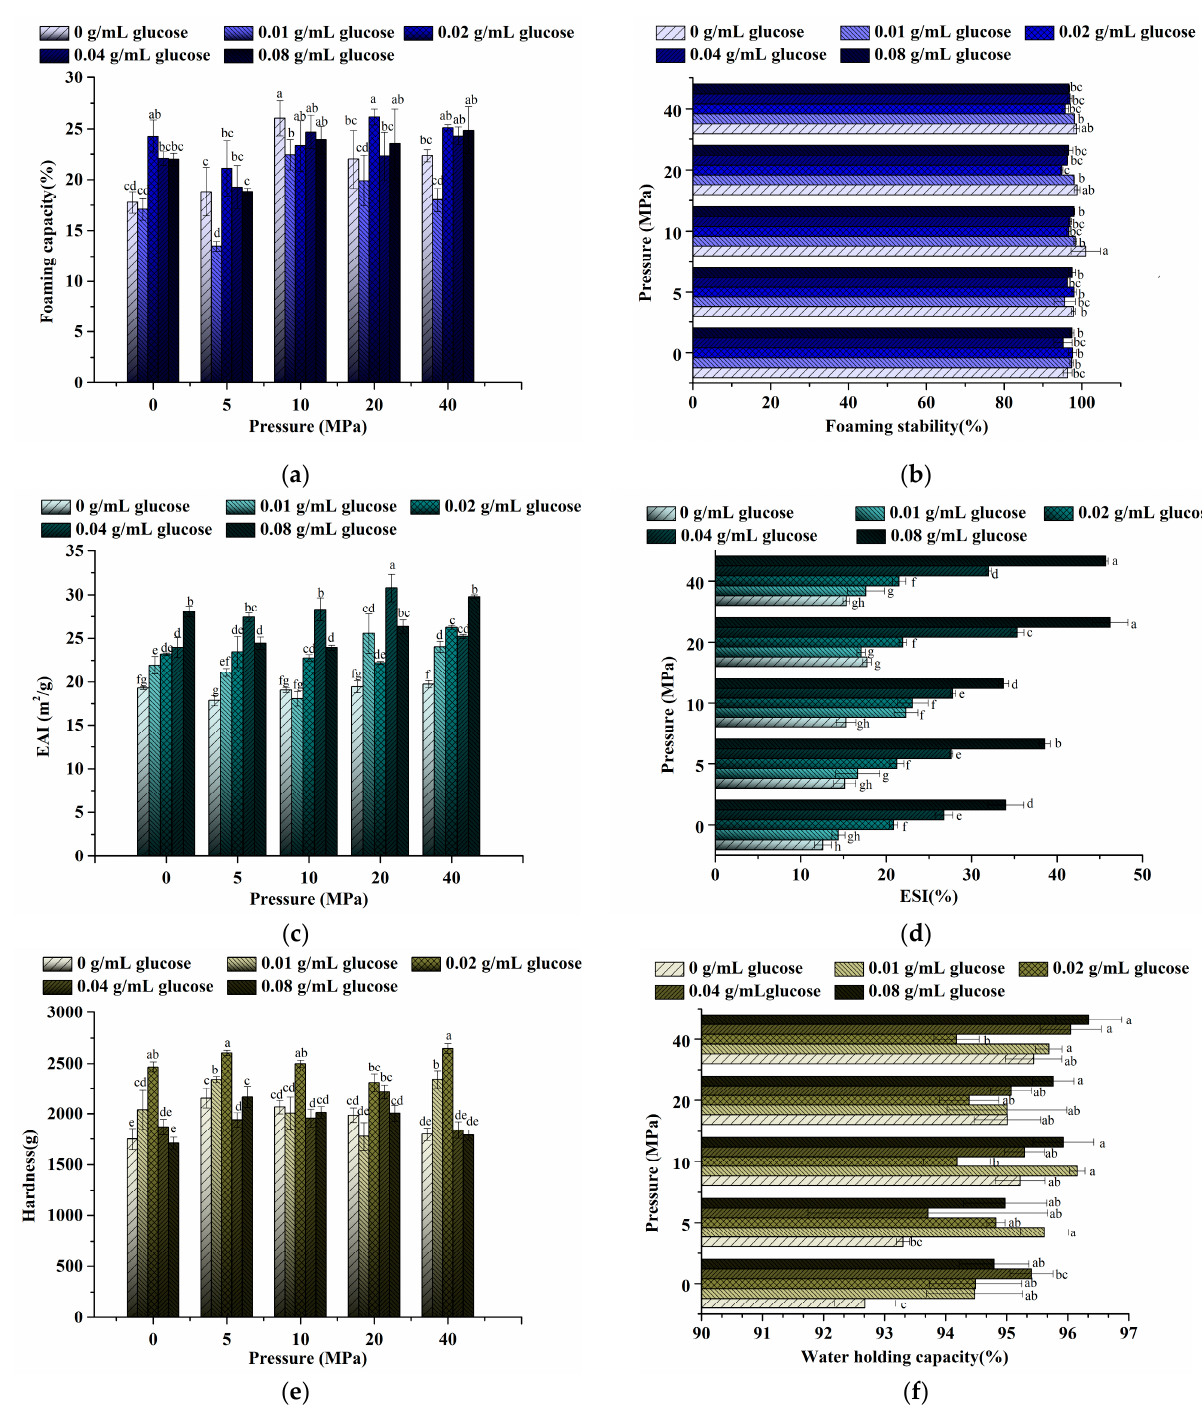
Figure 6. The processing properties of LWE under different homogenization pressure and glucose concentrations. Figures in turn are foaming capacity ( a ), foaming stability ( b ), emulsifying capacity ( c ), emulsifying stability ( d ), gel hardness, ( e ) and WHC ( f ). Significant differences were indicated with different letters ( p < 0.05).